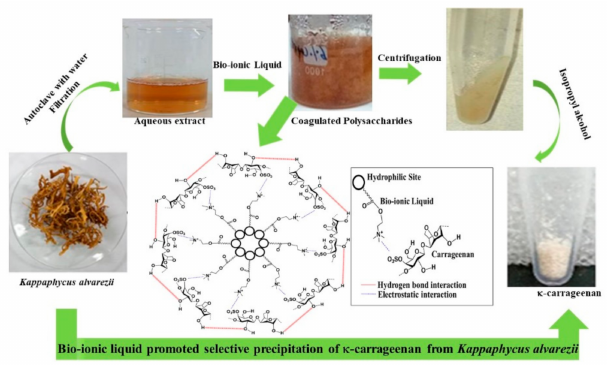
Figure 8. Extraction of carrageenan from Kappaphycus alvarezii using ionic liquids (permission from Publisher).